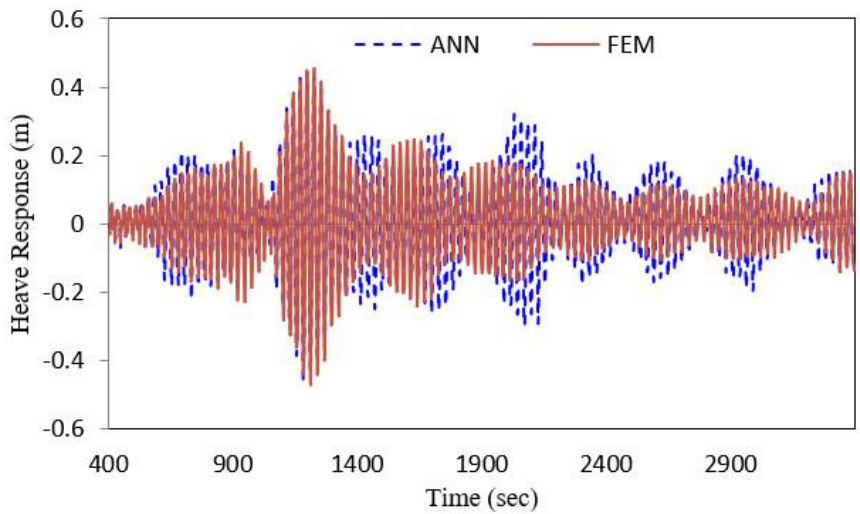
Figure 9. Heave response time history predicted for wave height of 6.65 m and wave period of 8.25 s.